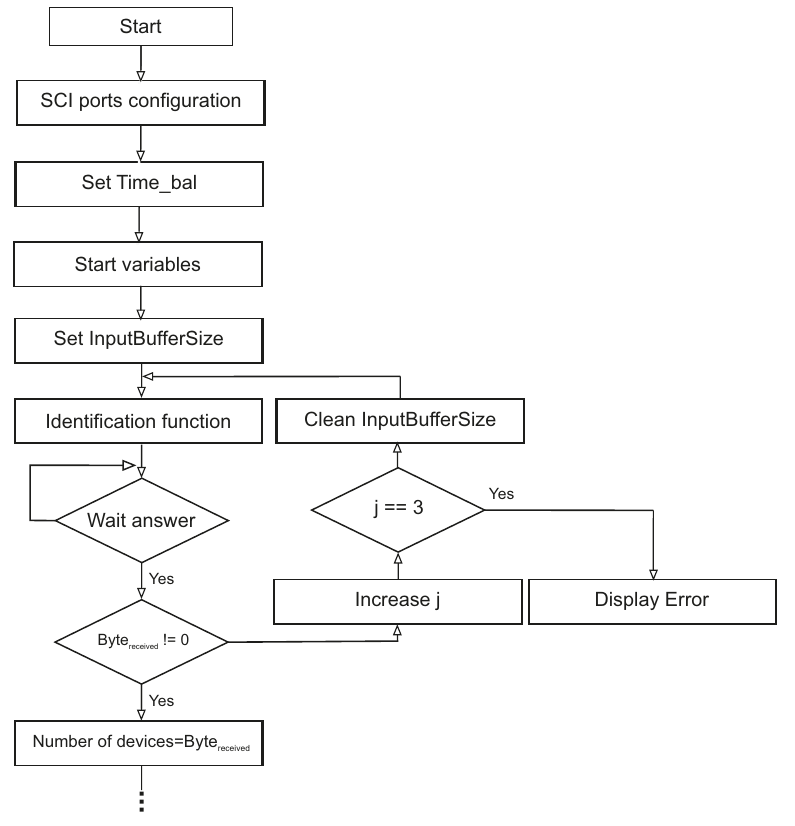
Figure 11. Flowchart of the program implemented in the main control unit—First Segment.